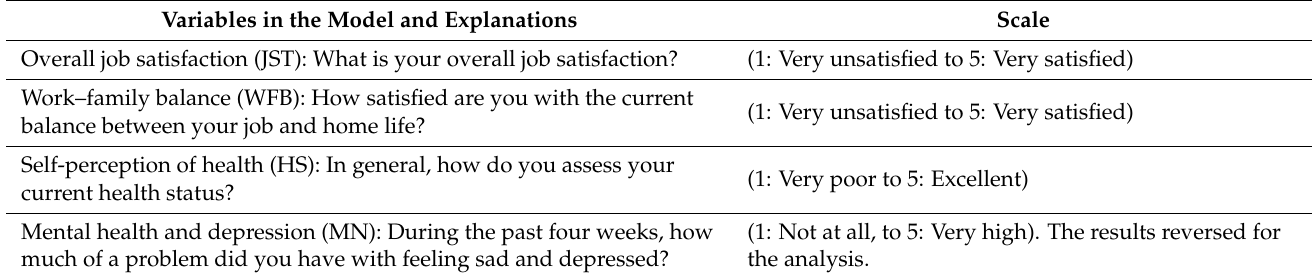
Table 1. Scale values and